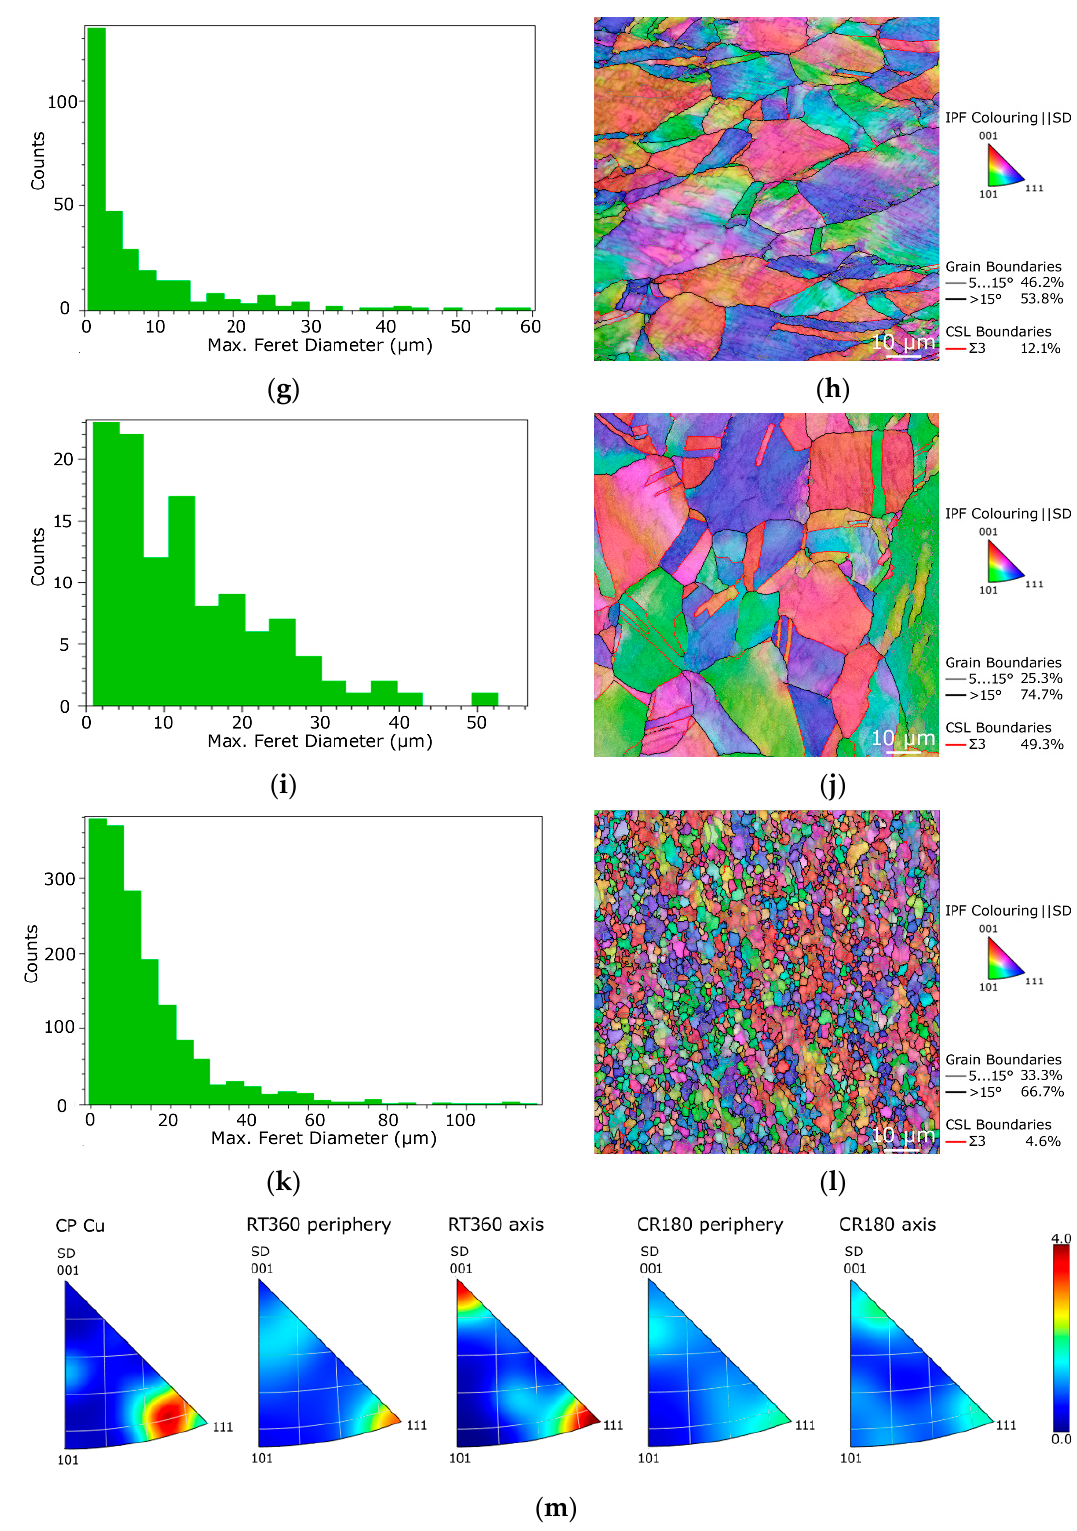
Figure 2. Grain size charts and OIM images, respectively, for: original Cu ( a , b ); RT360 specimen periphery ( c , d ); RT360 specimen axis ( e , f ); CR180 specimen periphery ( g , h ); CR180 specimen axis ( i , j ); CR360 specimen periphery ( k , l ). IPF images showing intensities (max. 4× random for all IPFs) of <111>||SD texture fi ber for CP Cu and regions of RT360 and CR180 specimens ( m ).